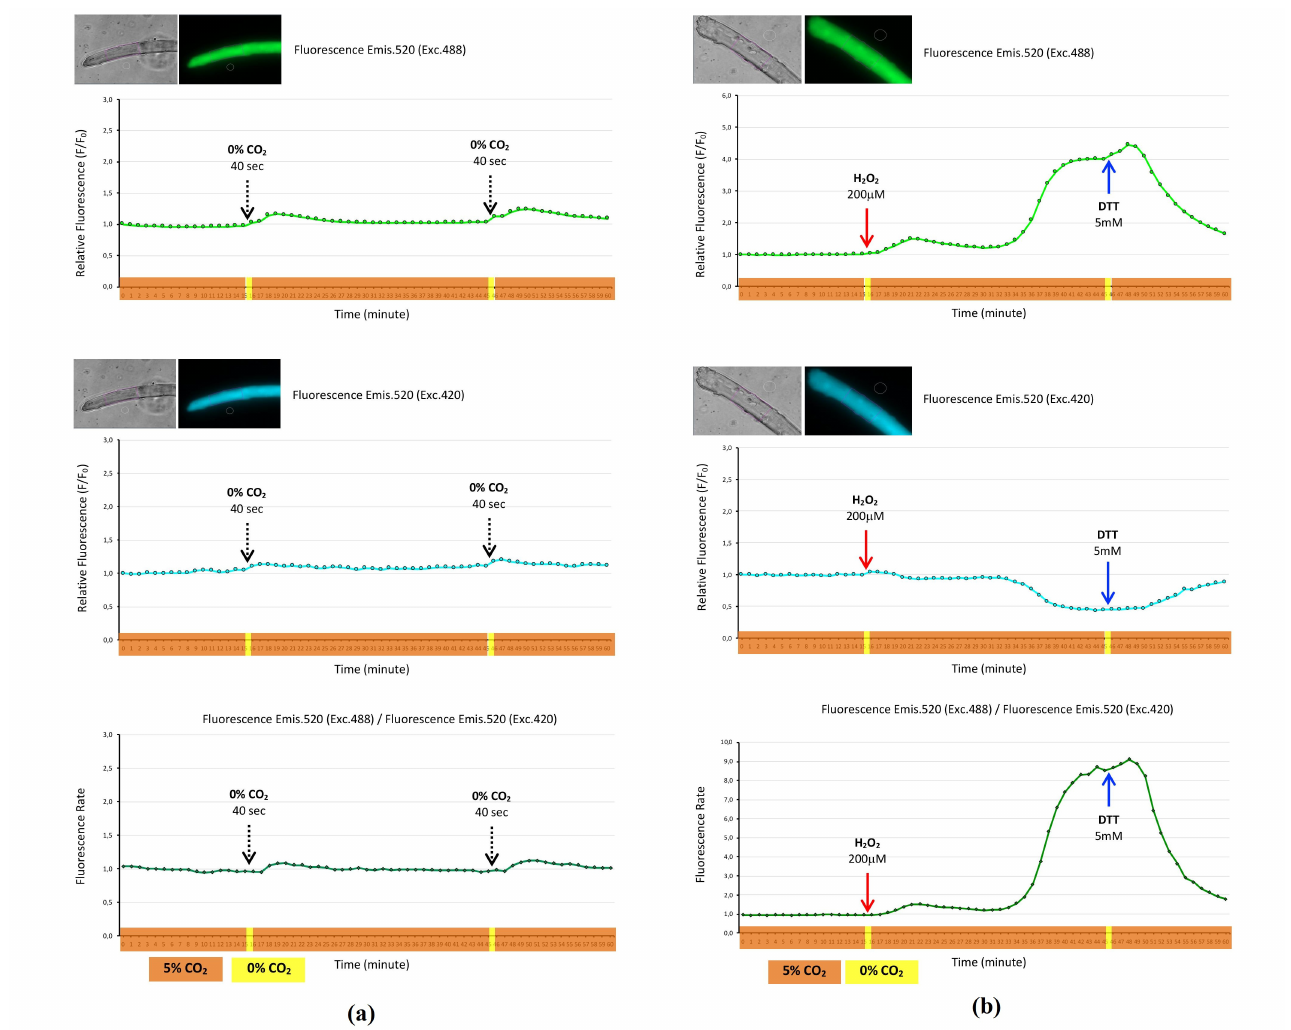
Figure 1. Hydrogen peroxide biosensor HyPer3 expressed in the cytosol of single skeletal muscle fibers. Fluorescence monitoring during a time course of 60 min, with fluorescence image registration every minute. Fibers were maintained at 37 ◦ C in a 5% CO 2 atmosphere (timeline highlighted in orange), with the exception of two timepoints at 15 and 45 min, where fibers were maintained respectively at 37 ◦ C in a 0% CO 2 atmosphere for 40 s (timeline highlighted in yellow). ( a ) Top panel presents the relative fluorescence (F/F0) of the HyPer3 biosensor’s fluorescence emission at 520 nm when excited at 488 nm of the fiber that expressed HyPer3. Fiber images: Transmission (grey) and fluorescence (green). Middle panel presents the relative fluorescence (F/F0) of the HyPer3 biosensor’s fluorescence emission at 520 nm when excited at 420 nm of the fiber that expressed HyPer3. Fiber images: Transmission (grey) and fluorescence (blue). Bottom panel presents the fluorescence rate of the HyPer3 biosensor, obtained from the registered fluorescence: Fluorescence emission at 520 nm when excited at 488 nm divided by the fluorescence emission at 520 nm when excited at 420 nm; ( b ) hydrogen peroxide 200 µ M was added to the fiber medium at the 15 min timepoint and dithiothreitol (DTT) 5 mM at the 45 min timepoint while the fibers were at 37 ◦ C in a 0% CO 2 atmosphere (timeline highlighted in yellow). Top panel presents the relative fluorescence (F/F0) of the HyPer3 biosensor’s fluorescence emission at 520 nm when excited at 488 nm of the fiber that expressed HyPer3. Fiber images: Transmission (grey) and fluorescence (green). Middle panel presents the relative fluorescence (F/F0) of the HyPer3 biosensor’s fluorescence emission at 520 nm when excited at 420 nm of the fiber that expressed HyPer3. Fiber images: Transmission (grey) and fluorescence (blue). Bottom panel presents the fluorescence rate of the HyPer3 biosensor, obtained from the registered fluorescence: Fluorescence emission at 520 nm when excited at 488 nm divided by the fluorescence emission at 520 nm when excited at 420 nm. (Supplementary enlarged figures.) Fibers expressing HyPer3 were exposed to H 2 O 2 and DTT. These reagents, which had been previously prepared in concentrated solutions, were added to the fiber medium